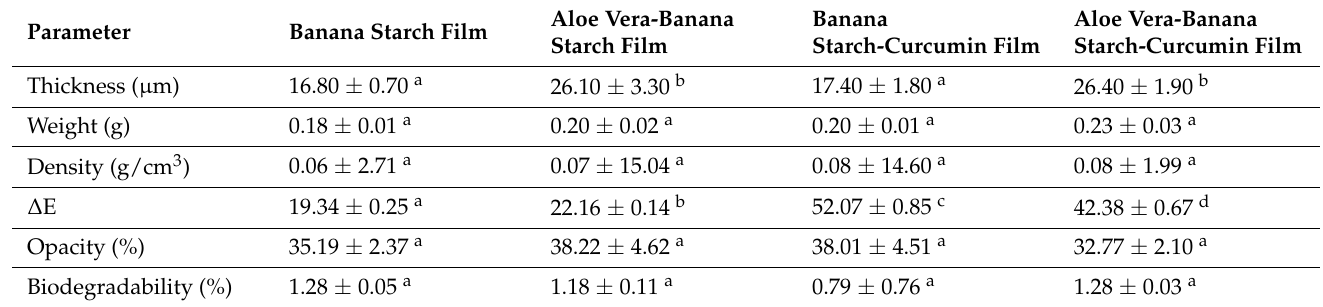
Table 1. Thickness, mass, density, surface color, opacity, and biodegradability of